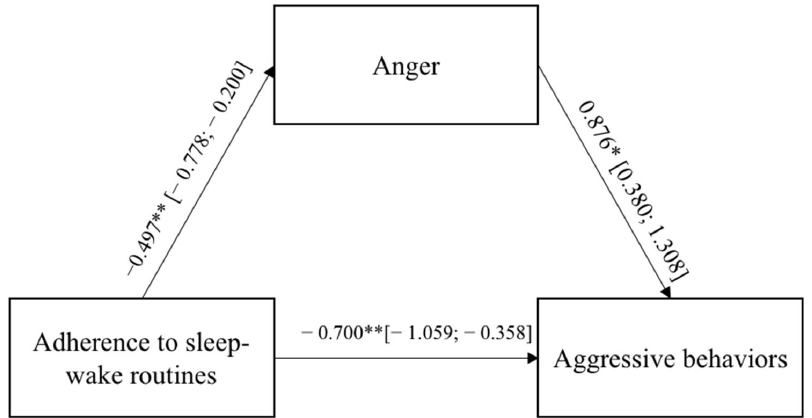
Figure 2. Results of Model 2. The bootstrap intervals of confidence are reported in brackets. * p < 0.05; ** p < 0.01; *** p < 0.001.